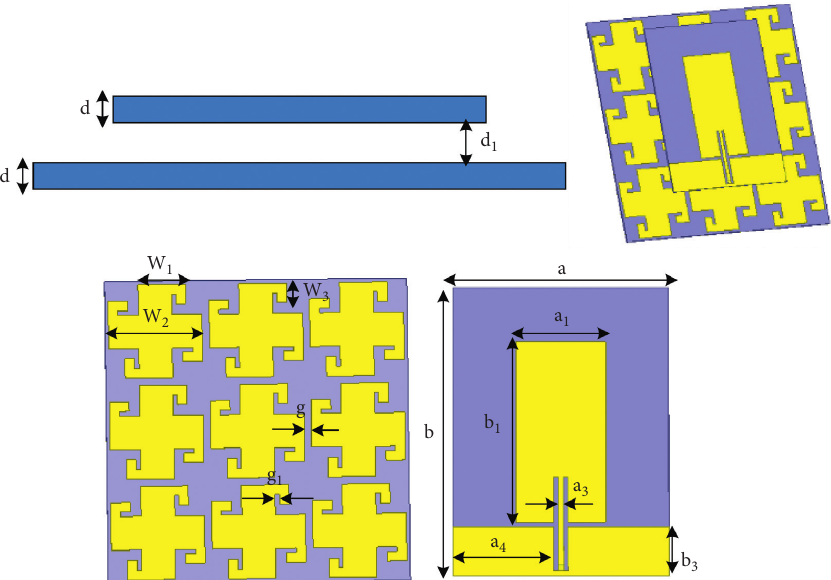
Figure 1: Configuration of the integrated planar antenna.